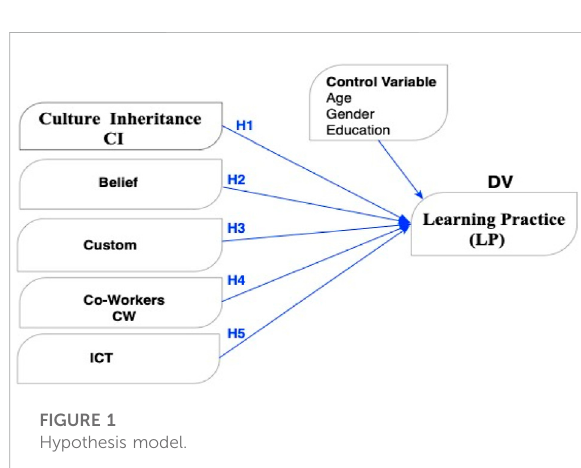
FIGURE 1 Hypothesis